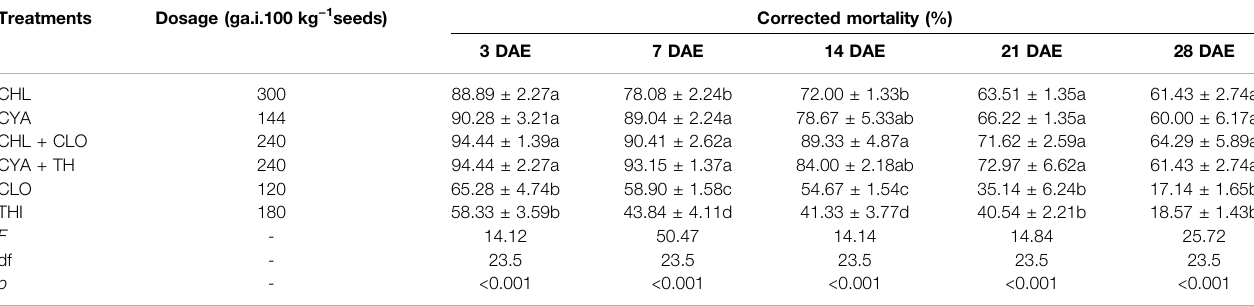
Values followed by different letters indicate signi fi cant differences among treatments with Tukey ’ s HSD test at p < 0.05.